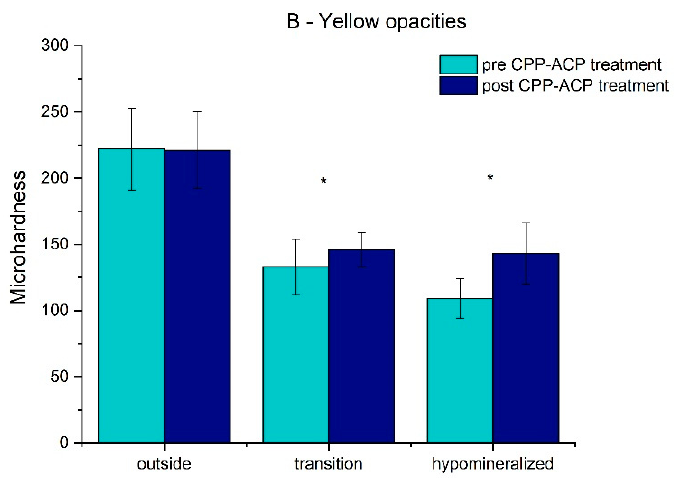
Figure 4. Bar chart of the mean values and standard deviation of microhardness in the yellow opacities group (* represent statistical significance).